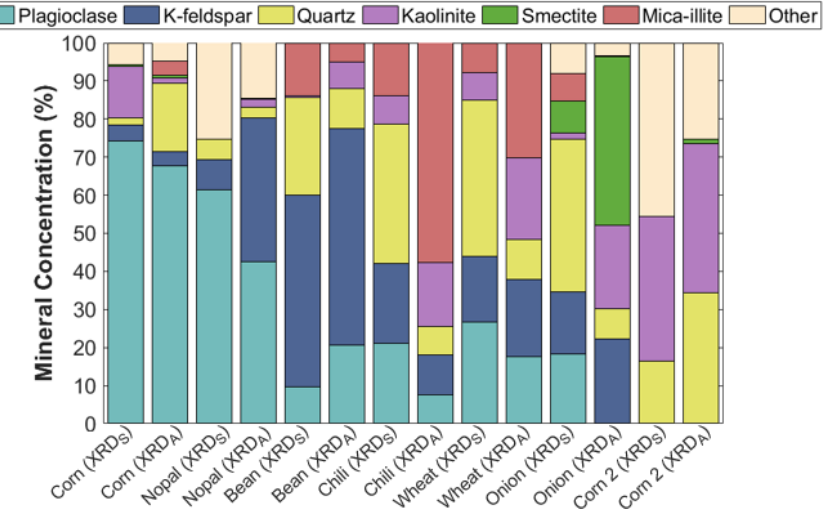
Figure 6. Summary of the mineralogical compositions of the aerosol particles generated in the laboratory for dp = 0.18–10µm (XRD A ) and soil samples collected in the field for particle sizes of < 425µm (XRD S ). The mineral phases were identified using X-ray diffraction